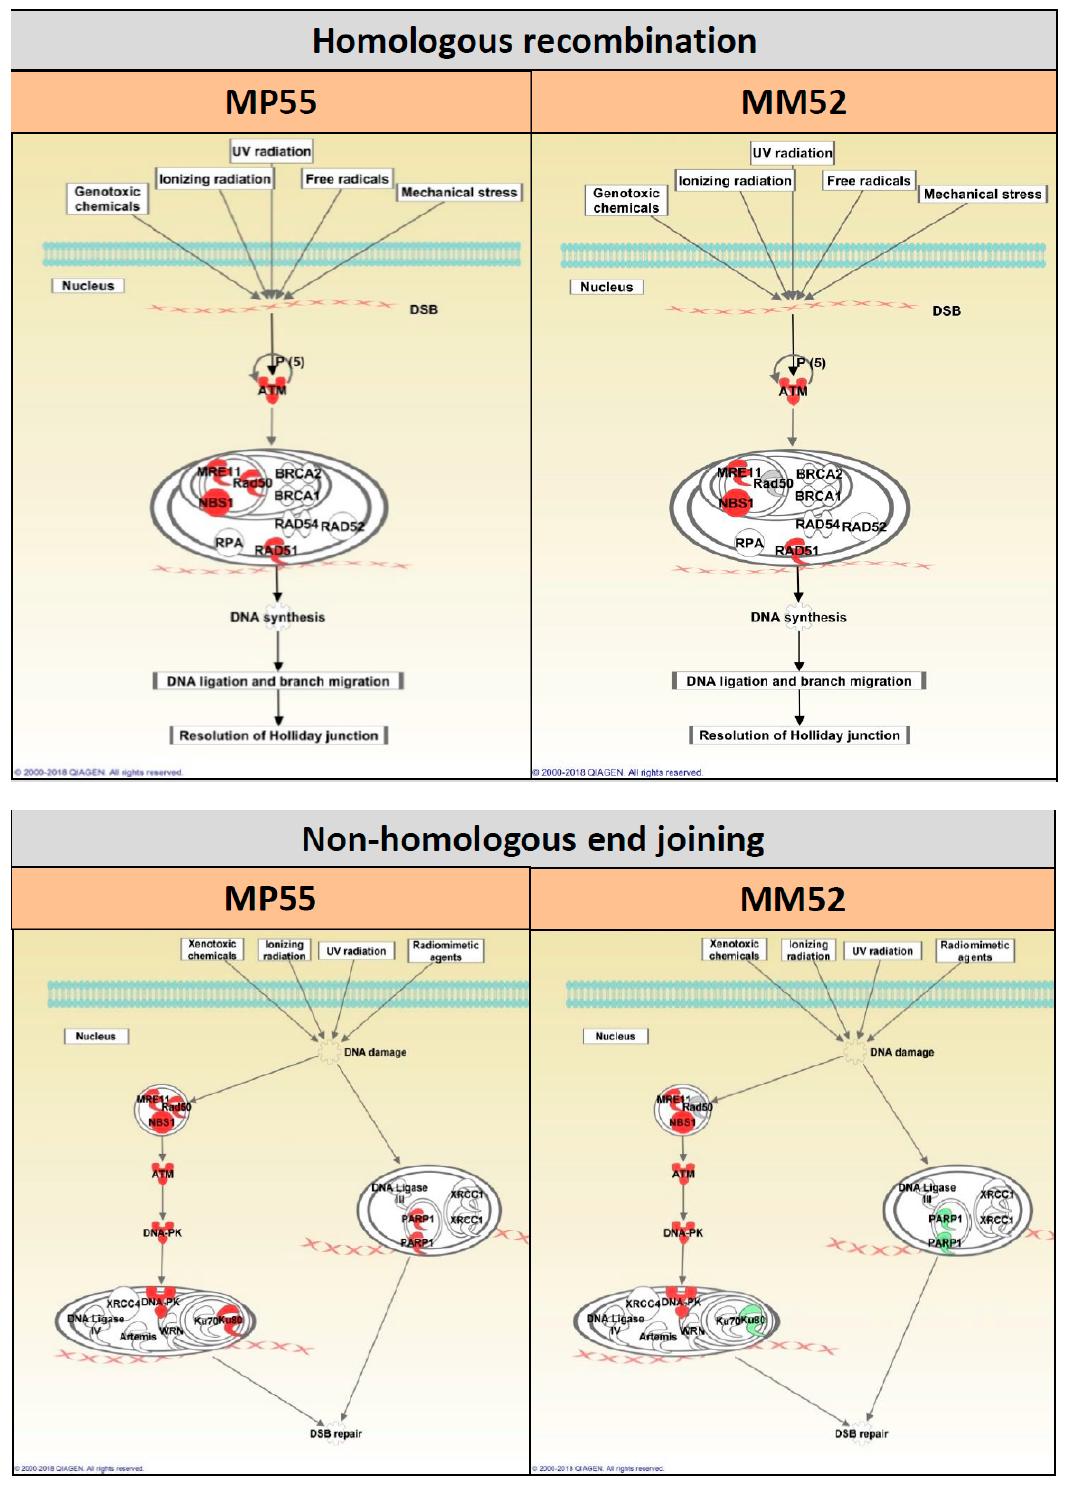
Figure 5. Schematic representation of HR- and NHEJ-related protein expression modifications in the two PDXs MP55 and MM52: Olaparib + DTIC versus DTIC. The intensity of color reflects fold change. Red color: higher (phospho-)protein expression in olaparib + DTIC than in DTIC alone. Green color: lower (phospho-)protein expression in olaparib + DTIC than in DTIC alone.